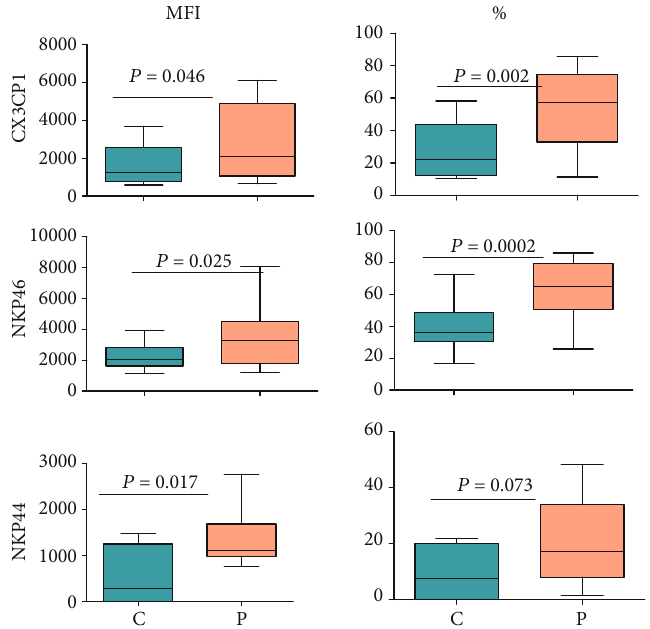
Figure 6: Expression of NKp46, NKp44, and CX3CR1 on CD 56bright/dim NK cells in CD patients and healthy controls. The fi gure shows MFI and percentages of NK cells expressing the markers. The box and whisker plots indicate median, interquartile ranges, and p values for 15 treatment-naïve CD patients and 15 healthy